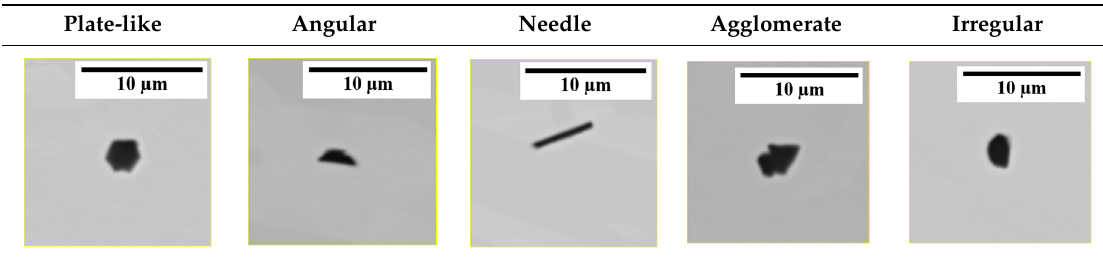
Table 5. Morphologies of AlN (pure) inclusions.